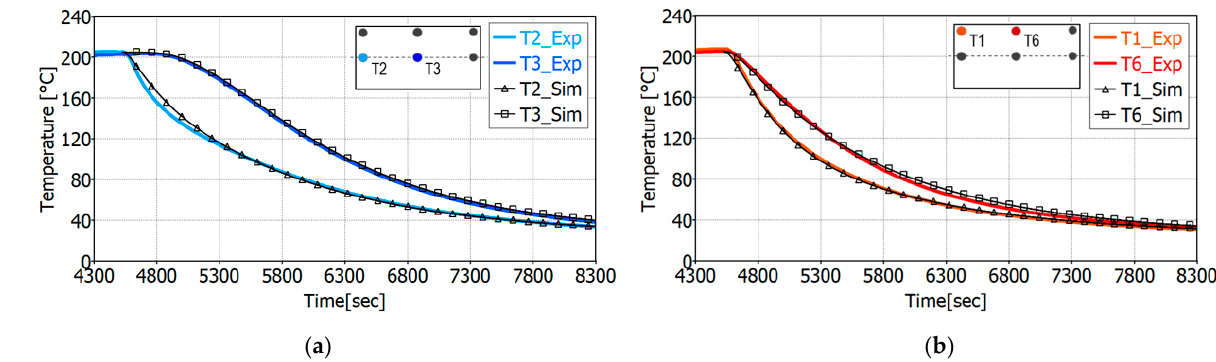
Figure 5. Temperature along the axial direction ( a ) in the center of the monolith and ( b ) close to the periphery. Test 1-Tinit = 200 °C, Inclination = 0°.